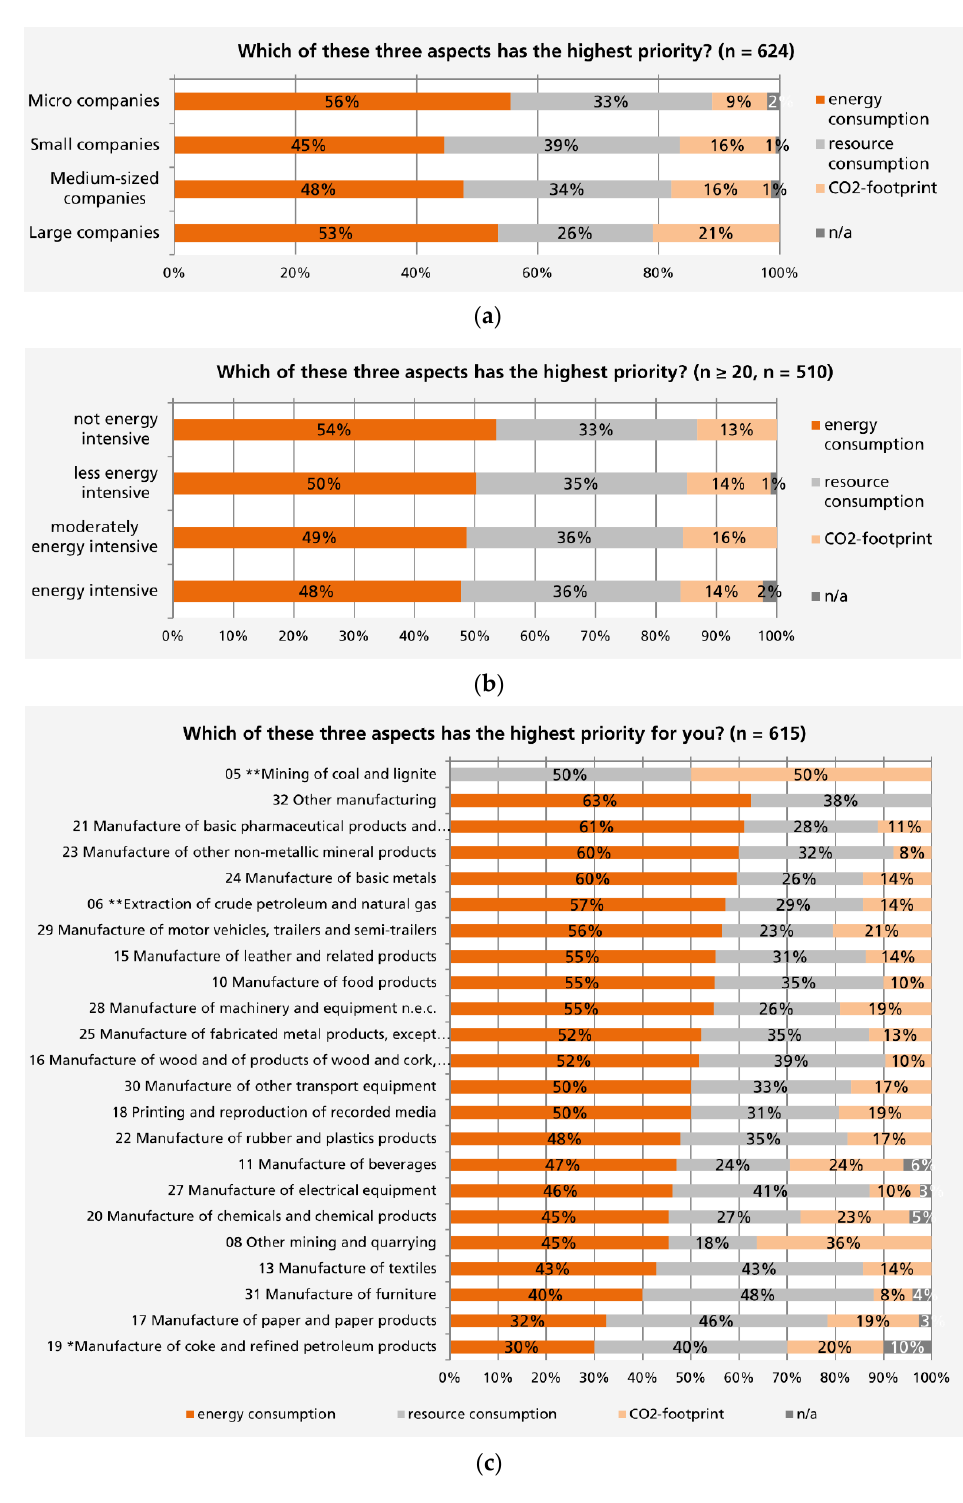
Figure 3. ( a ) Energy and resource and footprint — which factor has highest priority, by company size; ( b ) energy and resource and footprint — which factor has highest priority, by energy intensity; and ( c ) energy and resource and footprint — which factor has highest priority, by sector.